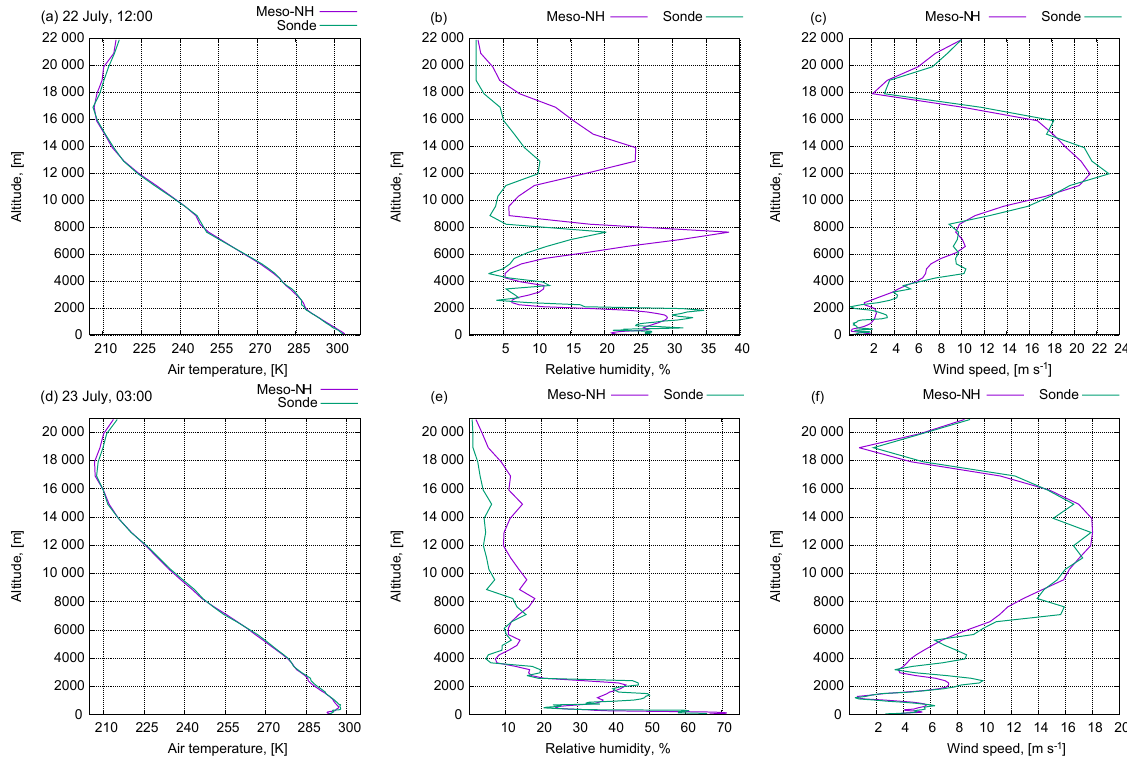
Figure 3. Examples of observed and simulated vertical profiles for 22 July at 12:00UTC and 23 July at 03:00UTC of air temperature (a, d) , relative humidity (b, e) , and wind speed (c, f)